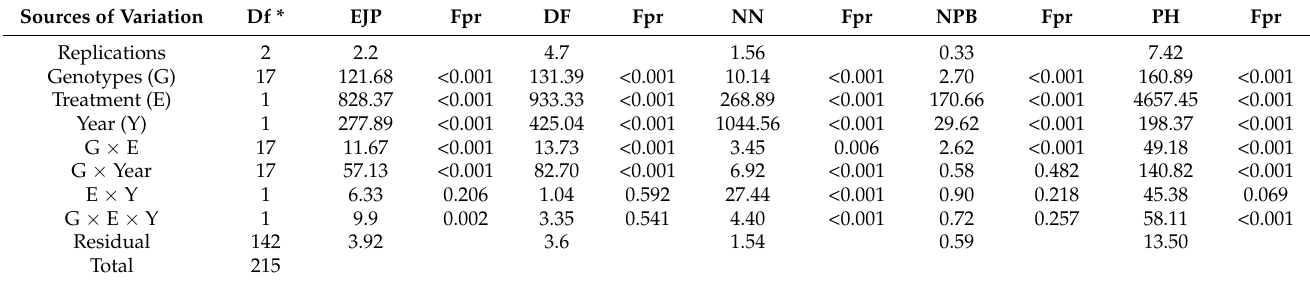
Table 1. Pooled analysis of variance for photoperiod-sensitivity-related traits of pigeonpea under normal daylength (ND) and extended daylength (ED) conditions at ICRISAT, Patancheru,